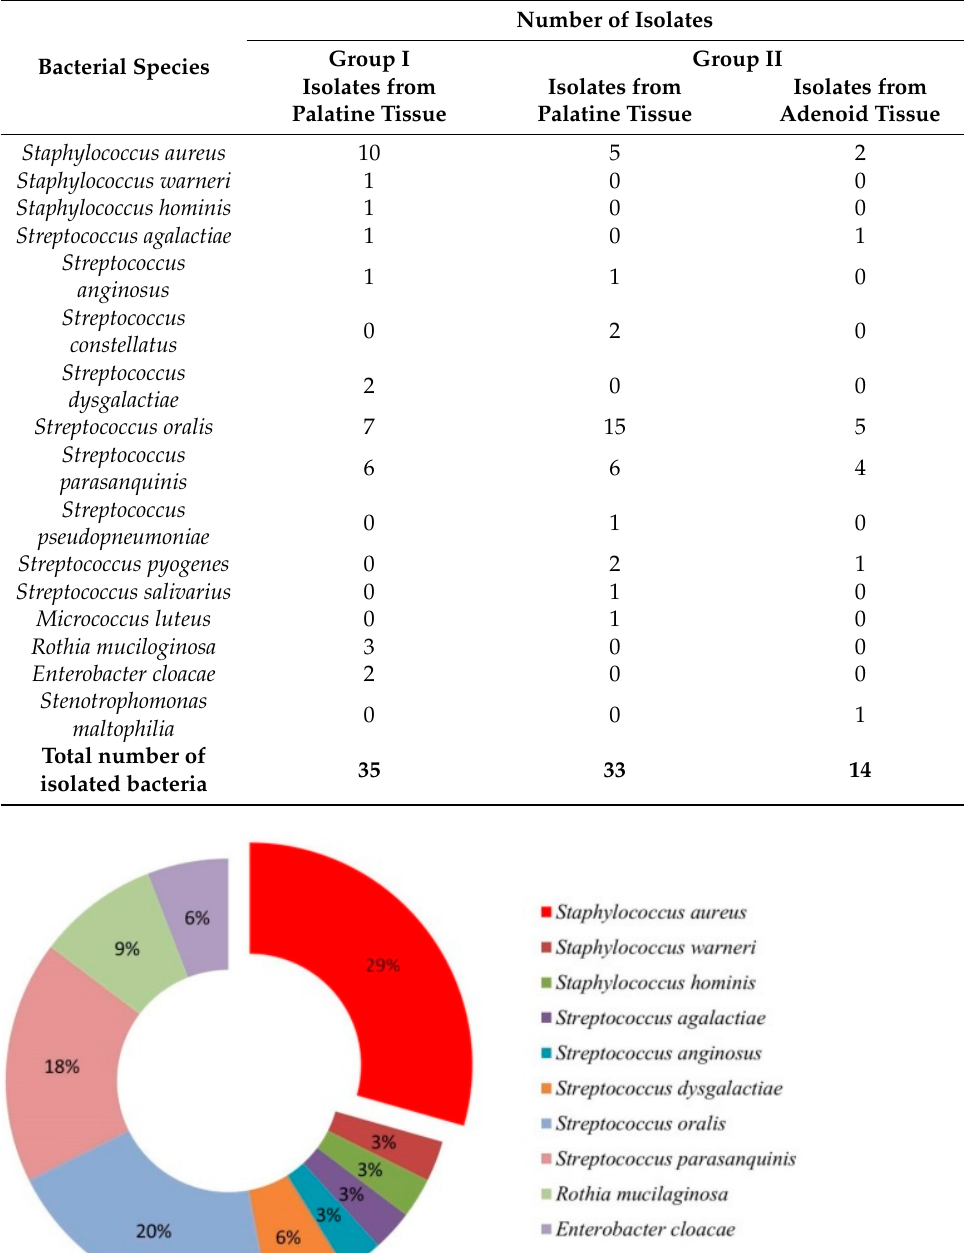
Table 3. Bacteria isolated from palatine and adenoid tissue from patients with chronic tonsillitis.